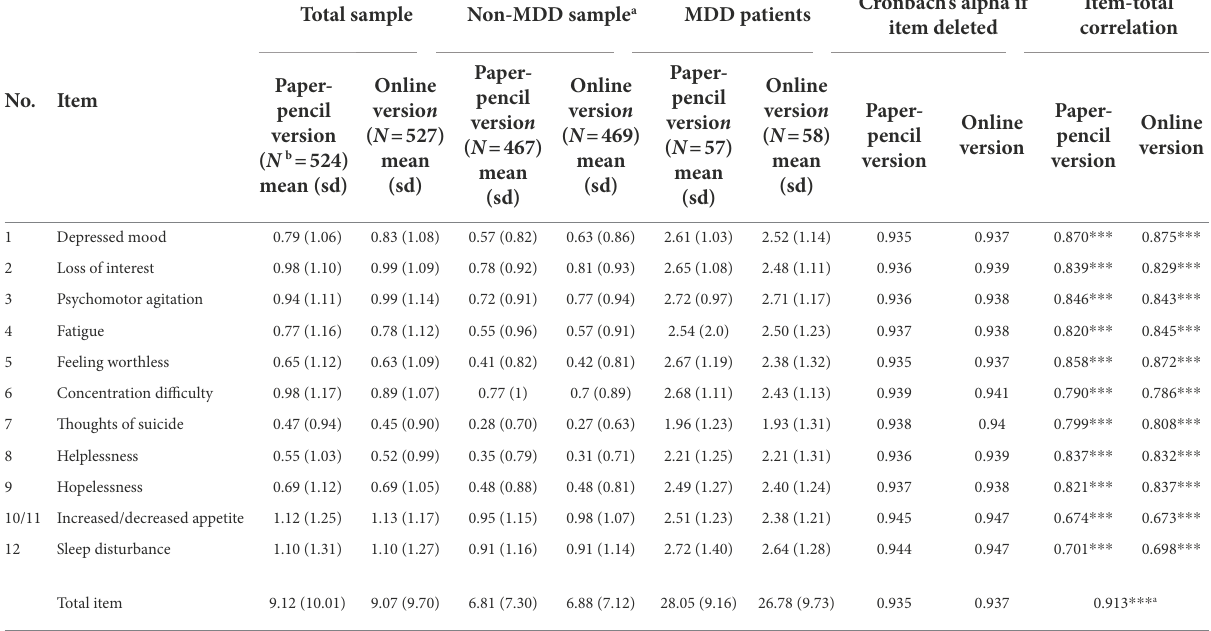
TABLE 2 Mean, standard deviations, and item-total correlations of